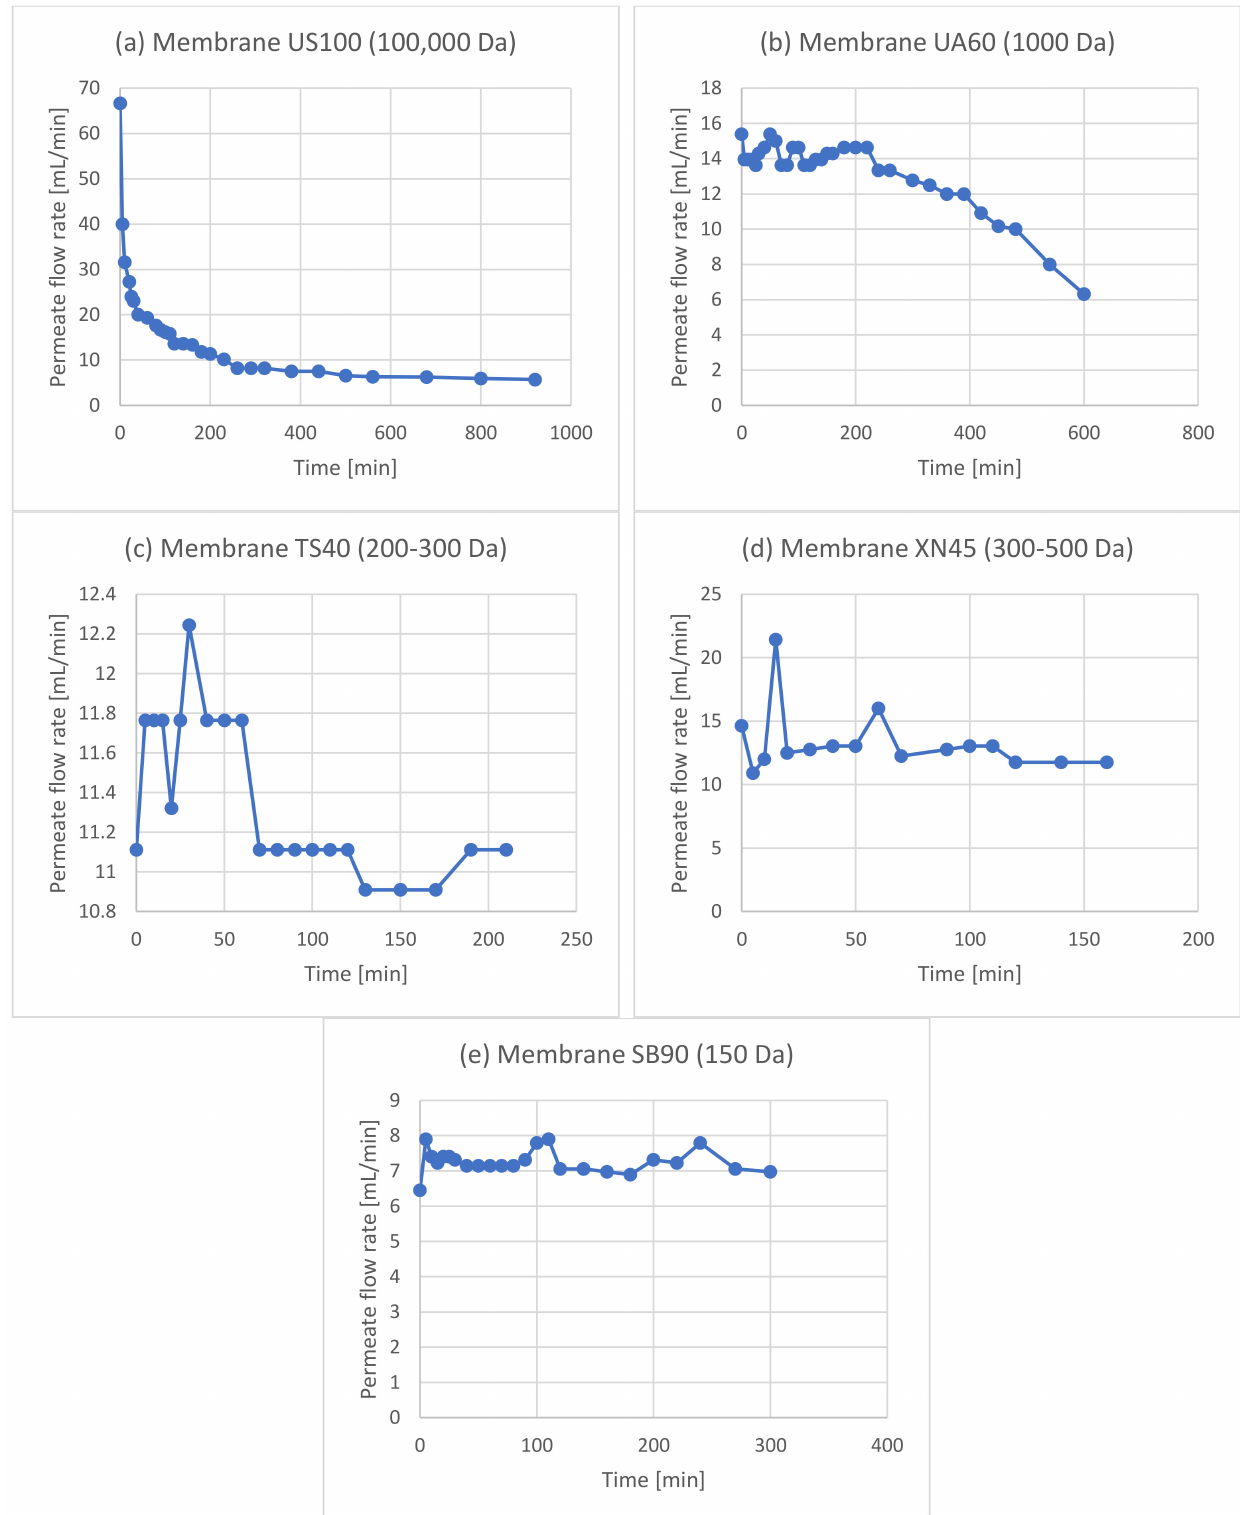
Figure A4. Permeate flow rates observed in the membrane treatment scheme after hydrolysis in which one ultrafiltration step (( a ) US100) was used in line with a nanofiltration membrane (( b ) UA60) and the permeate from the 1000 Da membrane was split into three equal parts and was treated with three different nanofiltration membranes (( c ) XN45, ( d ) TS40, ( e )